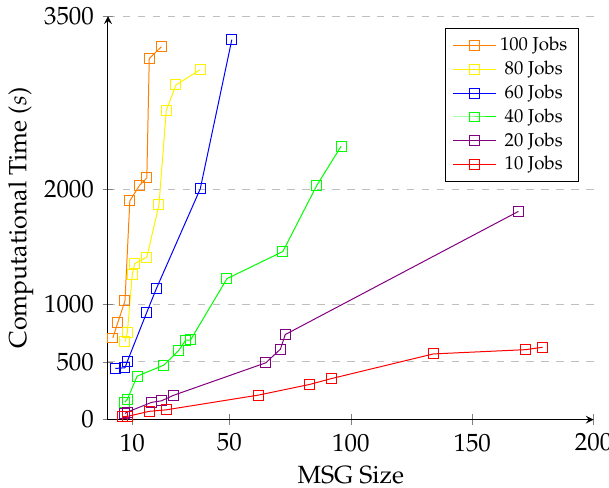
Figure 11. MSG computational time.